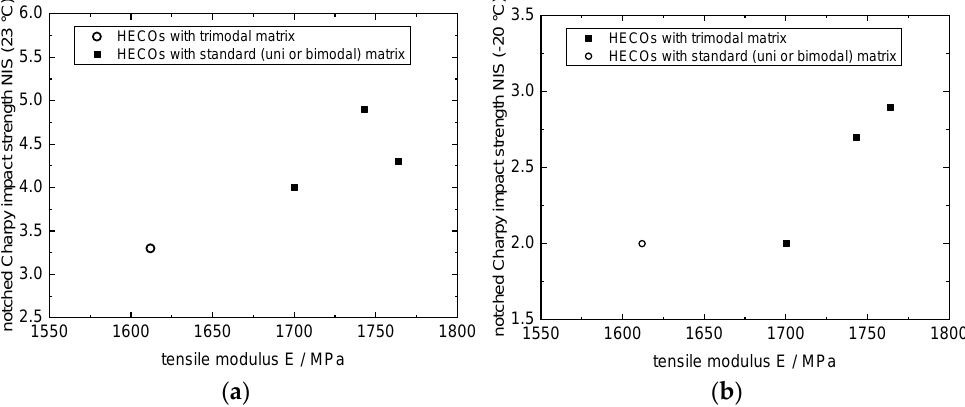
Figure 14. Stiffness–impact balance of HECOs with trimodal matrix compared to commercial refer- ences with unimodal matrix with NIS measured at different temperatures: ( a ) 23 °C and ( b ) −20 °C (data from [106] and commercial grades).